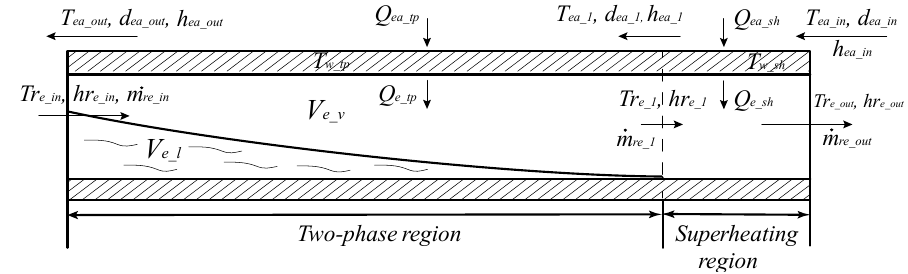
Figure 2. The schematic diagram of the two-region evaporator model.